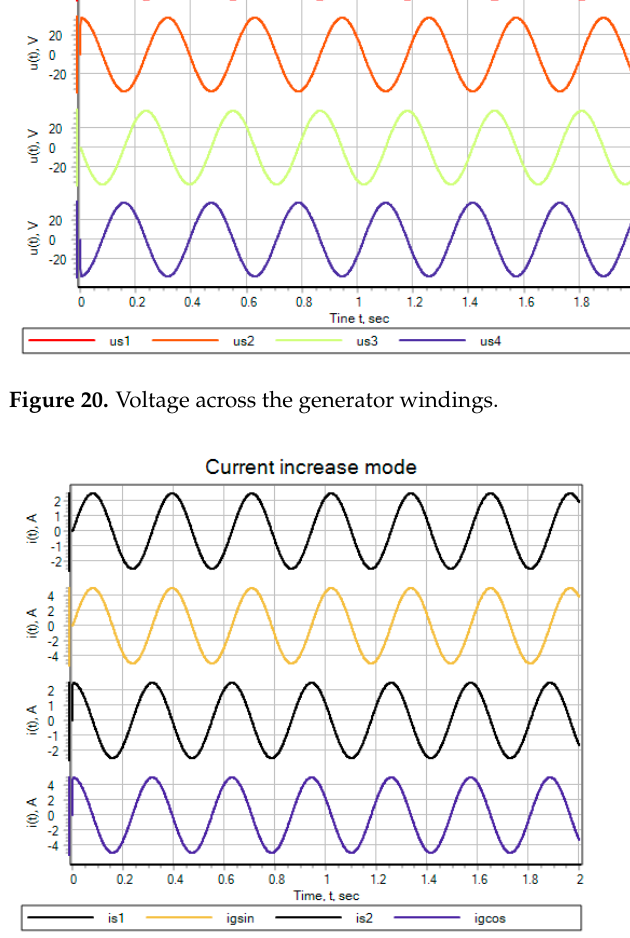
Figure 21. Load current with the stator windings connected in parallel.